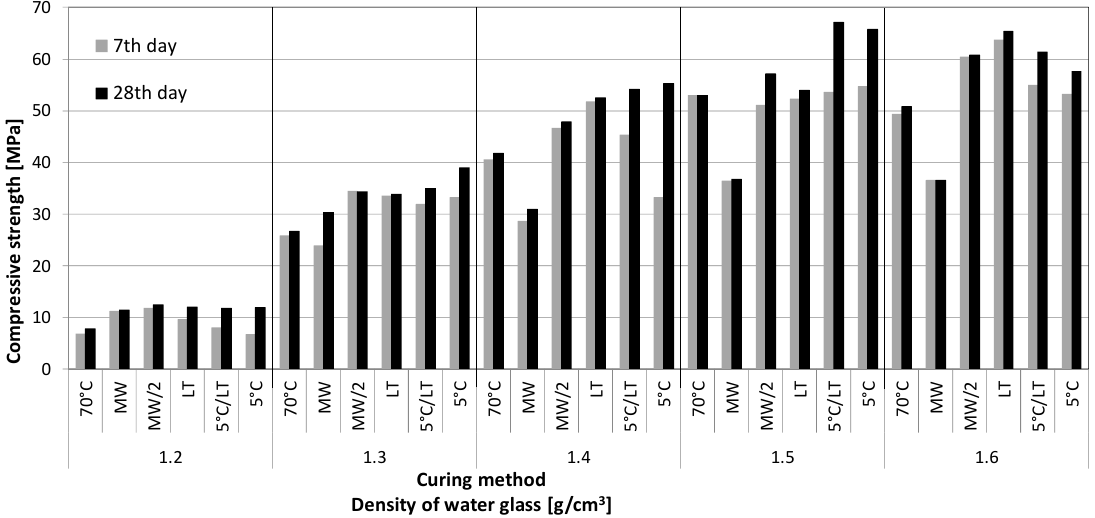
Figure 3. Influence of curing method and density of water glass on the compressive strength of geopolymers. Values were averaged from 5 measurements. The standard deviation was under 10% of the average value.